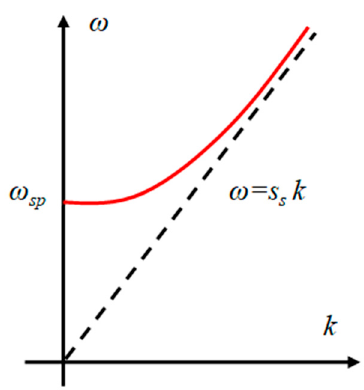
Figure 1. The schematic plot of the dispersion curve for sound waves in the ideal electron fluid of a superconductor.